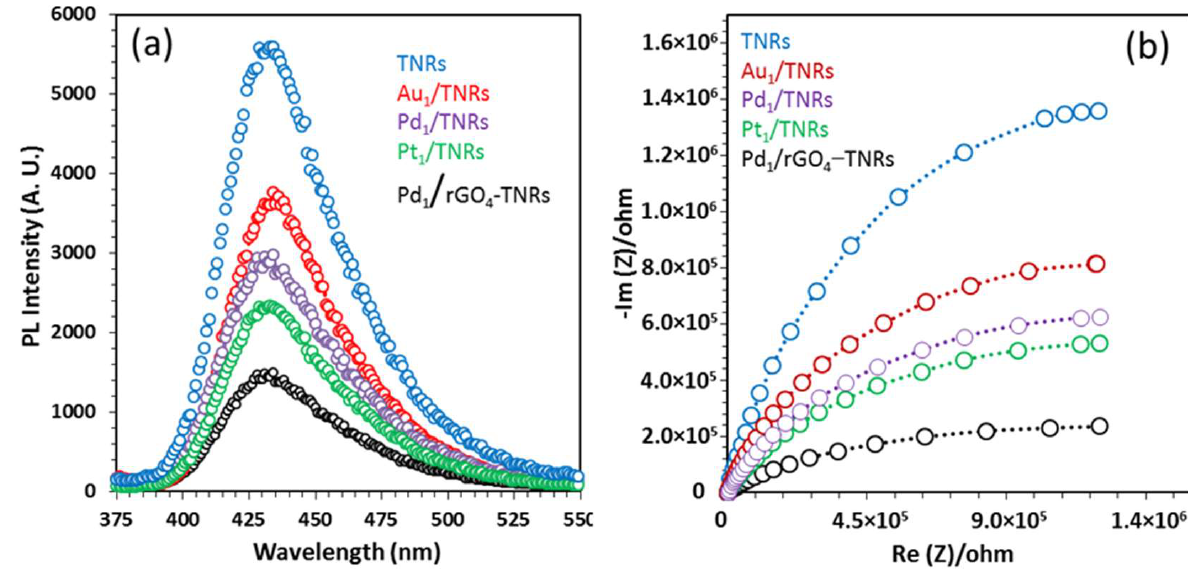
Figure 5. ( a ) Steady-state photoluminescence (PL) measurements and ( b ) EIS Nyquist plots of pristine TNRs, Pd 1 /TNRs, Pt 1 /TNRs, Au 1 /TNRs and Pd 1 /rGO 4 −TNRs.